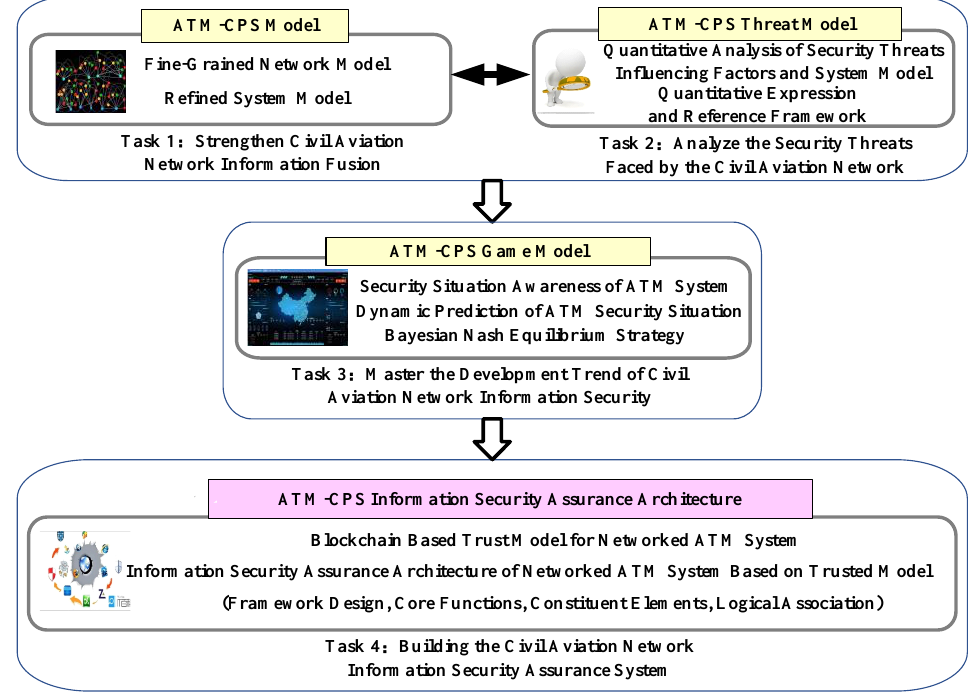
Figure 3. Research contents and the relationships among them.